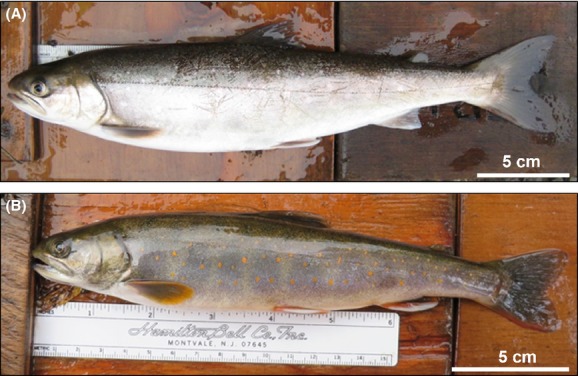
(A) Arctic char (Salvelinus alpinus) from Happy Creek, Lake Aleknagik, AK; note the silver body with white spots, narrow caudal peduncle and well-defined fork in the tail; (B) Dolly Varden (Salvelinus malma) from Yako Creek, Lake Aleknagik; note the small colorful orange spots along a darker green body, thick caudal peduncle, and paddle-shaped tail.